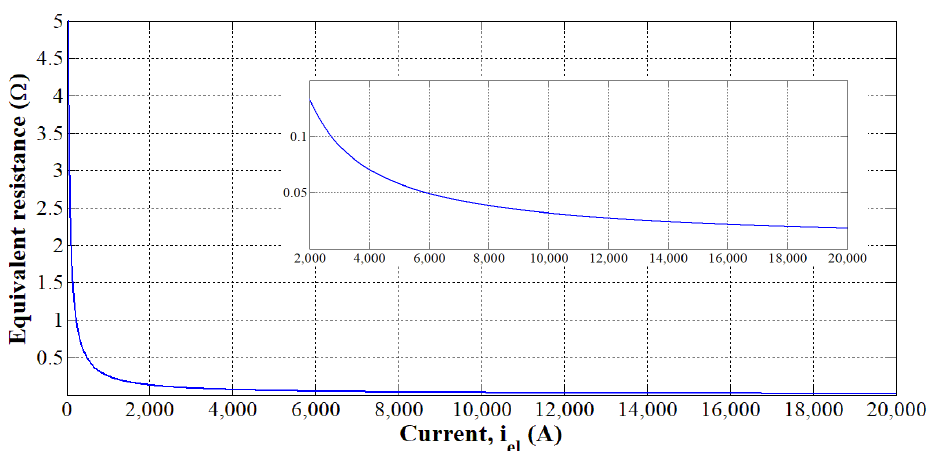
Figure 12. Static voltage-current curve of an alkaline electrolyzer (3 MW) [40].